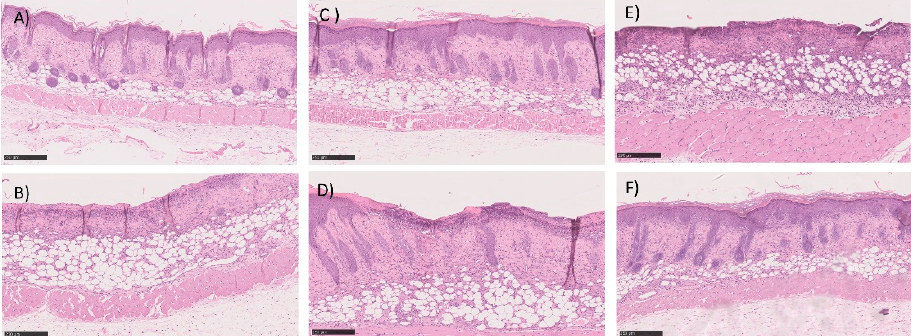
Figure 11. Histological section image of the skin of the mice after 5-days of treatment with ( A , B ) commercial cream of silver sulfadiazine, ( C , D ) commercial insulin in solution in POLX gel, and ( E , F ) insulin-loaded NPs in POLX gel. Scale bars 250 µ m (magnification 100 ×